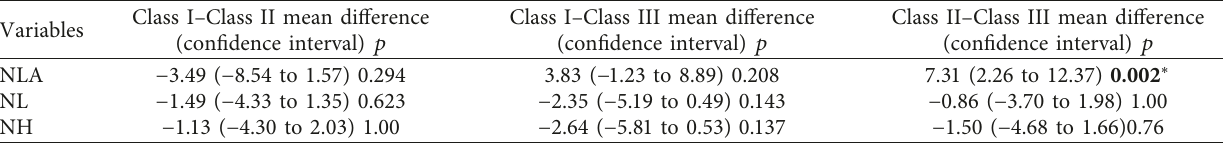
Table 5: Intergroup comparison of nose variables among different sagittal skeletal groups.